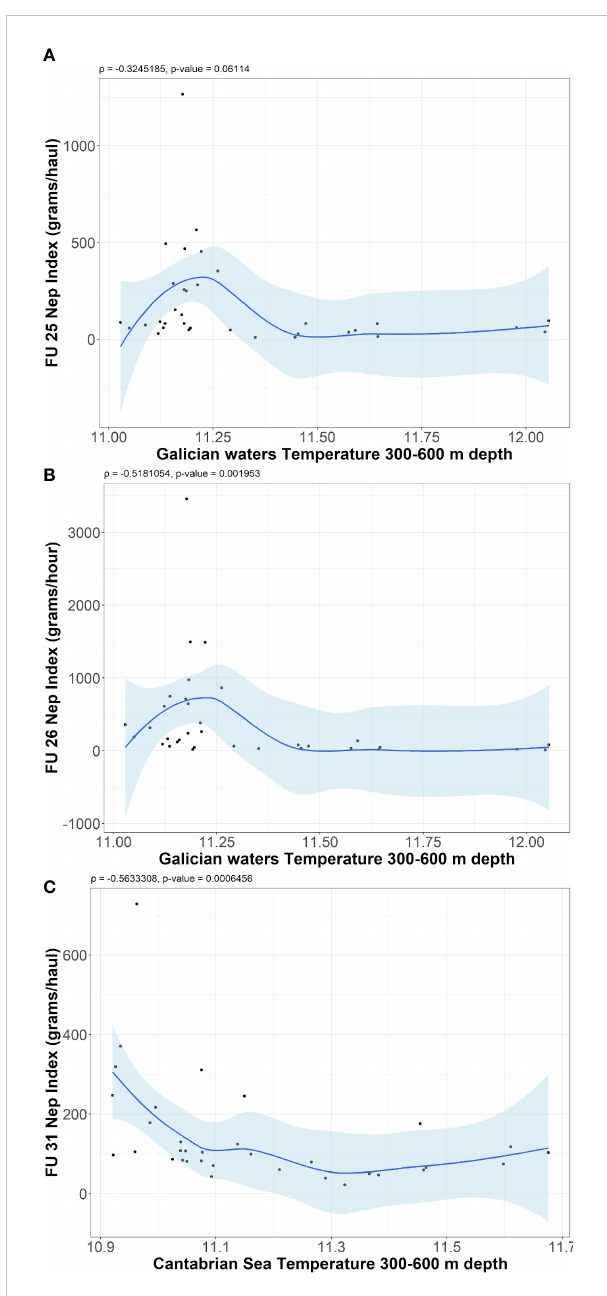
FIGURE 5 Annual Nephrops biomass indices vs. annual average temperature below mixed layer (TBwML), 1983-2017: FU 25 (North Galicia) (grams/haul) in Galician waters, (A) , FU 26 (West Galicia) (grams/ hour) in Galician waters (B) and FU 31 (Cantabrian Sea) (grams/haul) in Cantabrian Sea (C) , r is the Spearman correlation coef fi